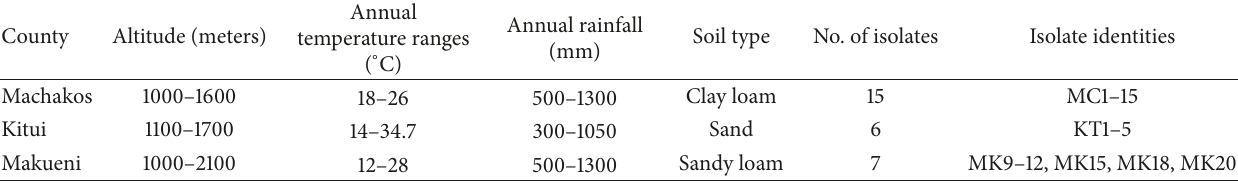
Table 1: Characteristics of counties in lower eastern Kenya and identities of rhizobia isolates per